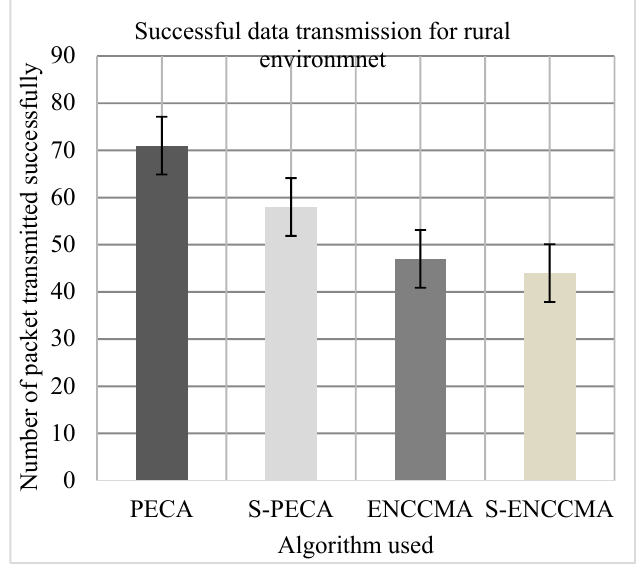
Figure 15. Successful transmission performance for rural.